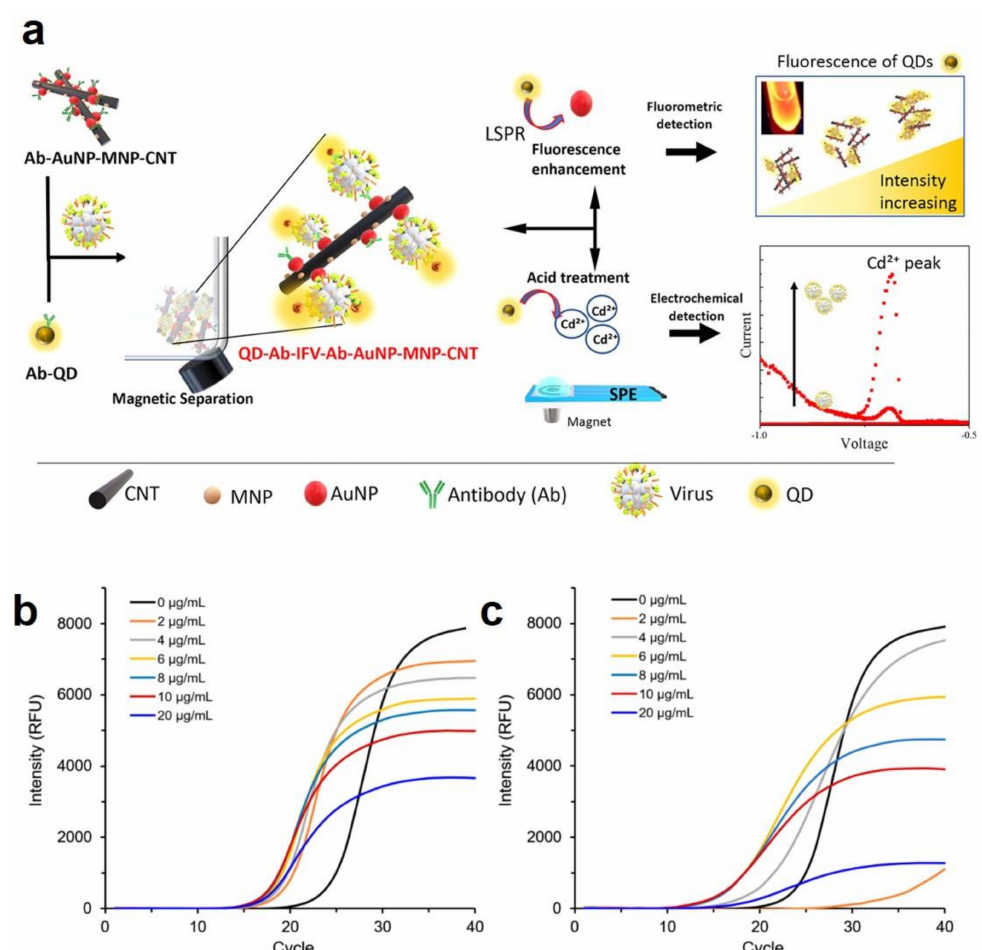
Figure 6. ( a ) Schematic illustration of the optical/electrochemical detection process of the Influenza virus based on imple- mentation of plasmonic nanocomposites and quantum dots. Reproduced with permission [94], Copyright 2021, American Chemical Society. The improvement of the PCR efficiency (nano-PCR based on pan-type primers) through inclusion of GO-AuNPs at different concentrations for the purpose of quantification of FMDV O-type ( b ) and FMDV A-type ( c ). Reproduced with permission